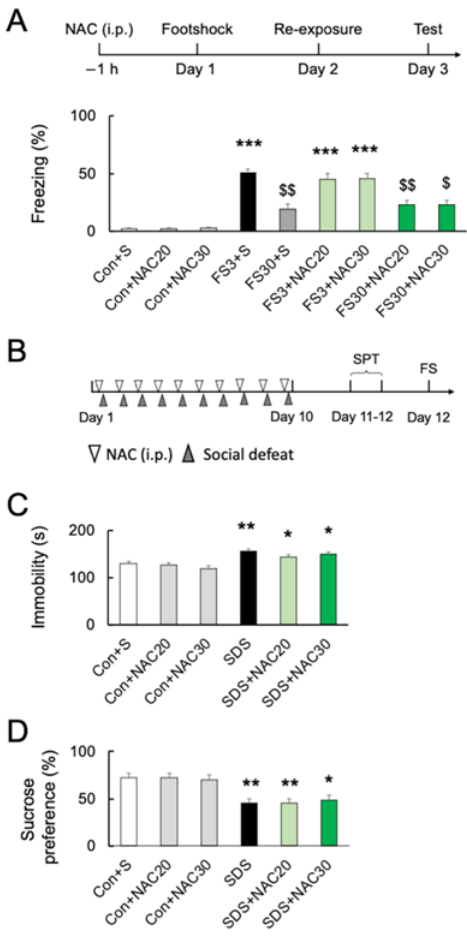
Figure 3. Effects of NAC on acute and chronic stress-induced behaviors. ( A ) Experimental schedule and the effects of NAC (20 and 30 mM) pretreatment on freezing time after acute footshock stress. *** p < 0.001, vs. non-stressed control mice. $ p < 0.05, $$ p < 0.01, vs. FS3 + S. Con, without footshock. FS3, mice after footshock with short-duration re-exposure. S, saline. FS30, mice after footshock with long-duration re-exposure. ( B ) The schedule of the chronic social defeat stress (SDS) experiments. ( C ) The effects of NAC pretreatment (20 and 30 mM) on immobility time in the forced swim test after chronic social defeat stress. * p < 0.05, ** p < 0.01, vs. non-stressed control mice. ( D ) The effects of NAC pretreatment (20 and 30 mM) on sucrose preference after chronic social defeat stress. * p < 0.05, ** p < 0.01, vs. non-stressed control mice. All data are presented as MEAN ±